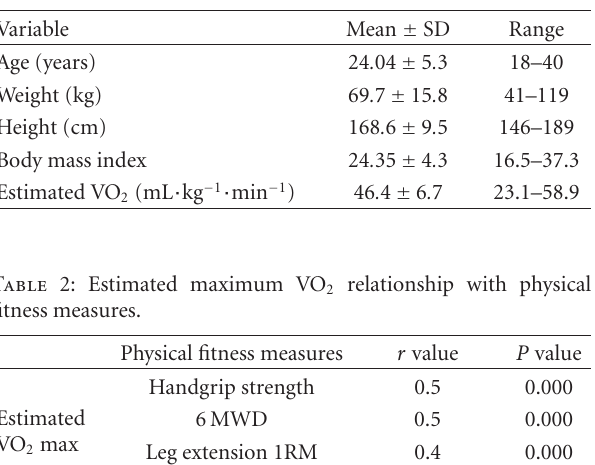
Table 1: Participant characteristics ( n = 188).